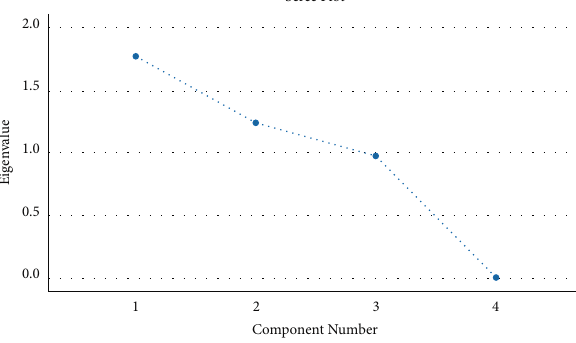
Figure 4: Factor eigenvalue distribution. Table 11: Component score coefficient matrix.